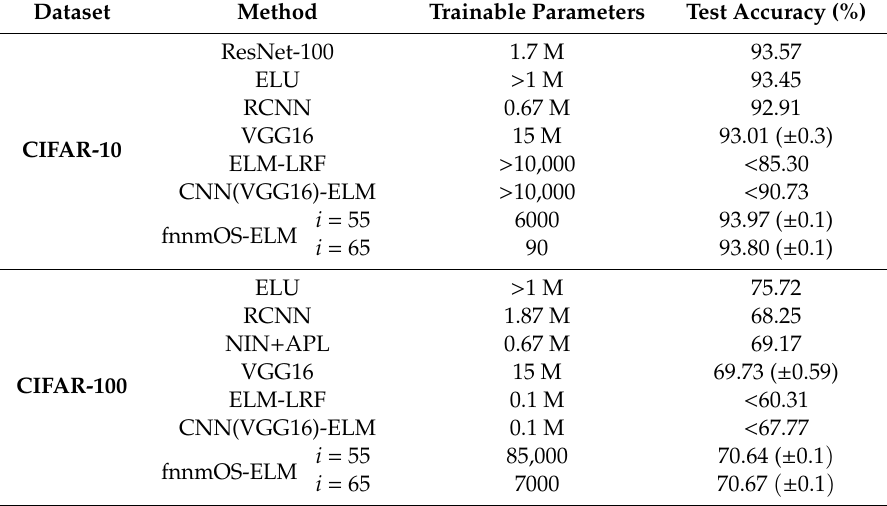
Table 4. Trainable parameters and test accuracy of several methods on the CIFAR-10 and CIFAR-100